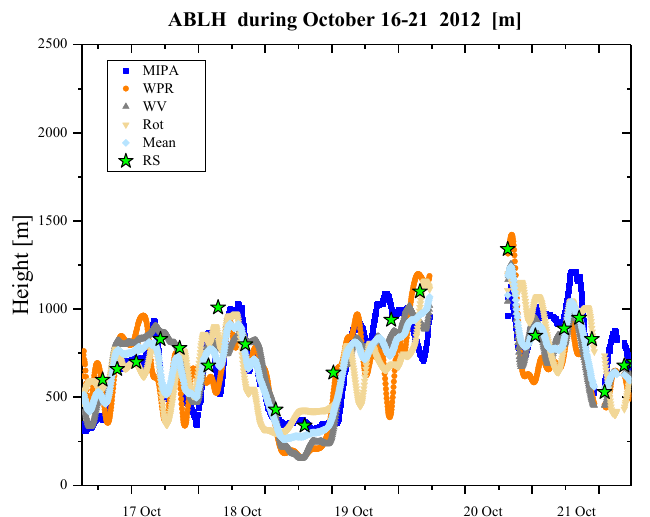
Figure 2. Comparison of ABLH estimated using different methods with reference values obtained from the temperature gradient technique applied to on-site radiosonde data (green stars) during the period from 16–21 October 2012.